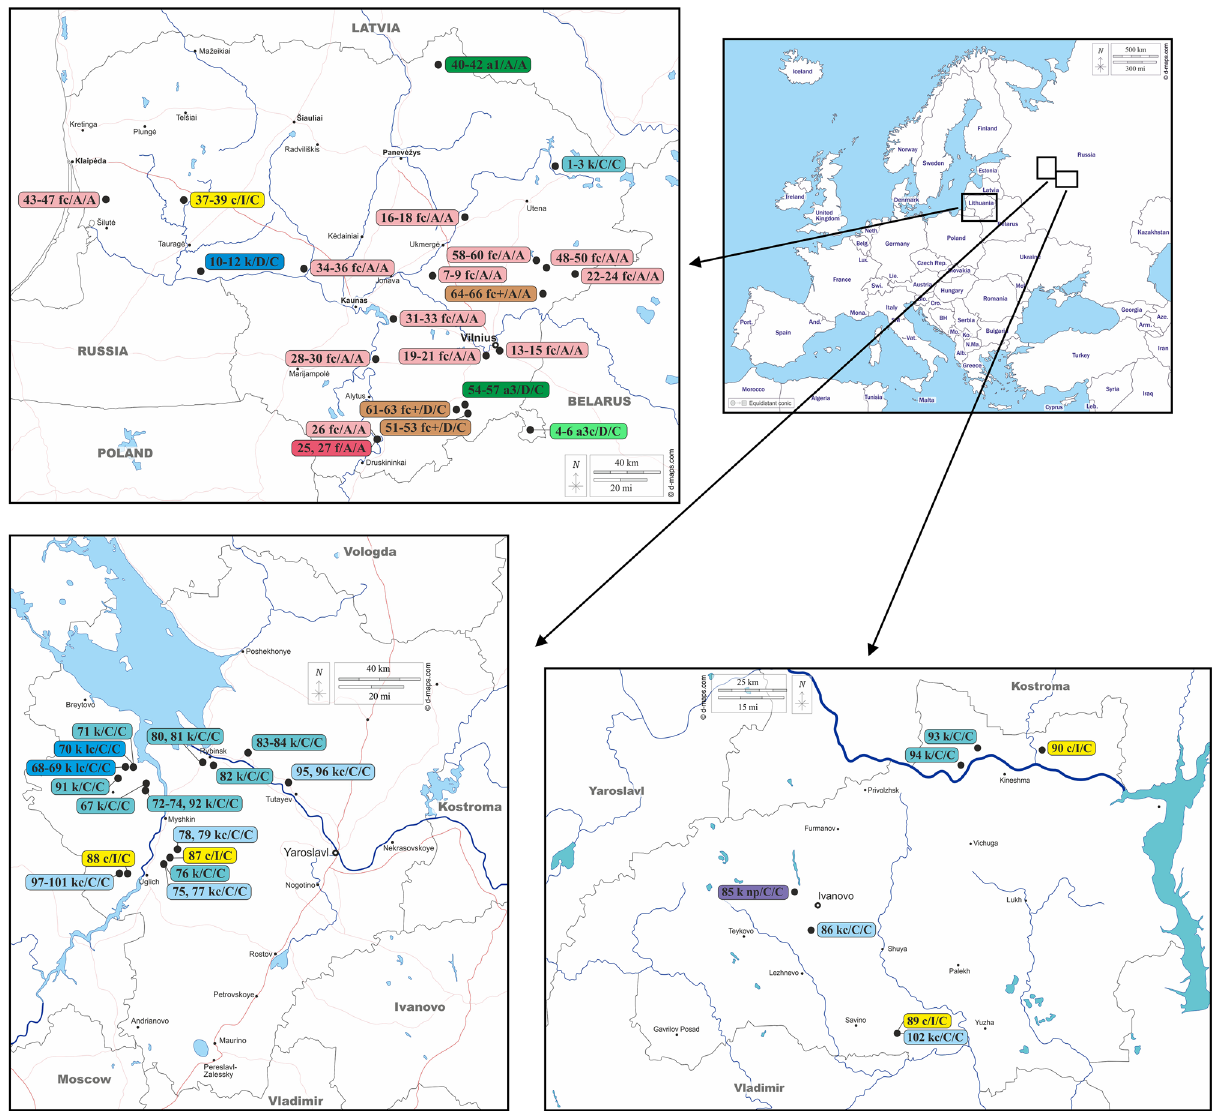
Figure 1. Study area and distribution of studied samples of Ranunculus section Batrachium . Sample marks include sample number or numbers, ITS info, rpl32-trnL and petL-psbE haplotypes according to Supplementary data: Table S1, for example, 34–36 fc/A/A means that samples 34–36 from Lithuania, the Dubysa River have hybrid ITS inherited from R . circinatus and R . fluitans , the rpl32-trnL haplotype A and petL-psbE haplotype A. (The basis of the maps were taken from d-maps.com Lithuania https://d- maps. com/ carte. php? num_ car= 26445 & lang= en; Ivanovo https://d- maps. com/ carte. php? num_ car= 73493 & lang= en; Yaroslavl https://d- maps. com/ carte. php? num_ car= 93710 & lang= en; Europe https://d- maps. com/ carte. php? num_ car= 4576& lang=